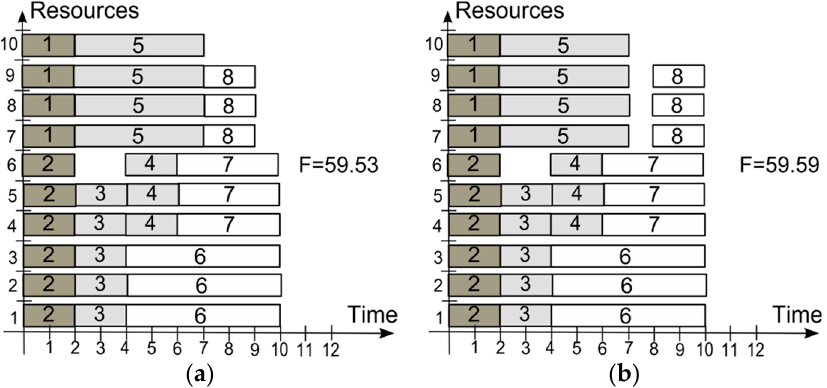
Figure 7. ( a ) Schedule generated for the activity list {1, 2, 3, 4, 5, 6, 7, 8} with the allocation of resources determined by the ISH-UA procedure. ( b ) Schedule improved by the right-shift procedure.